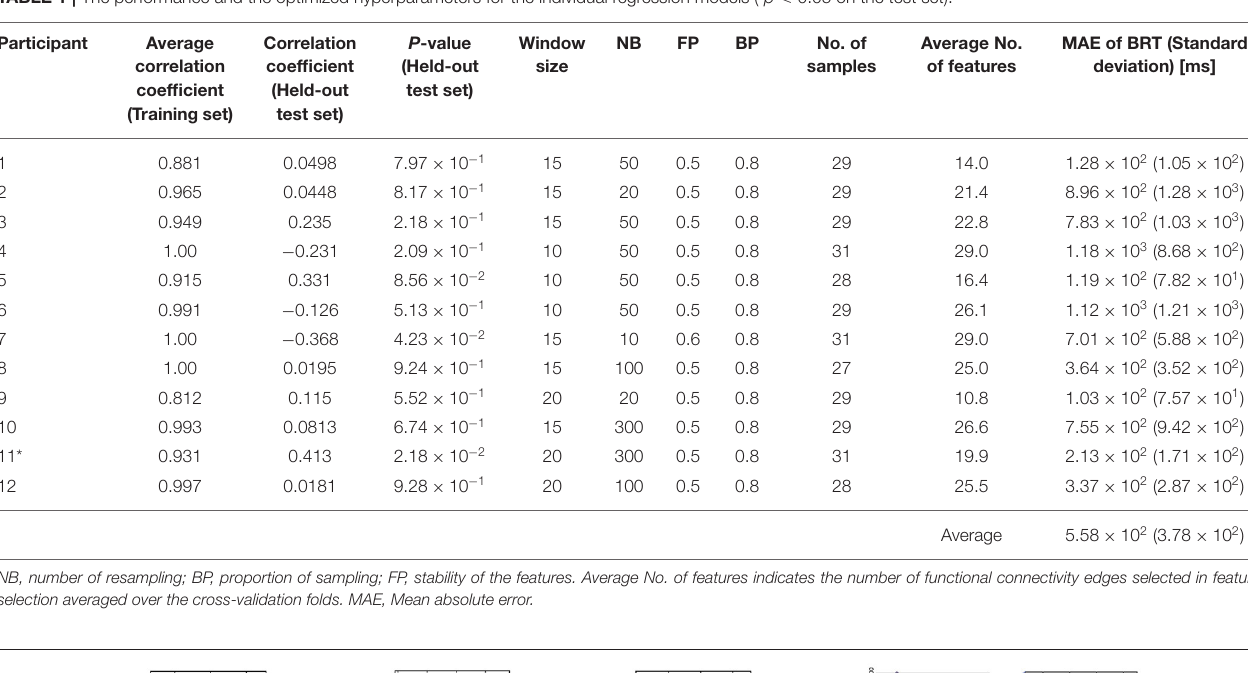
on the dendrogram indicates the distance threshold used for splitting into 5 clusters). Commonly selected FC edges in clusters are shown in the connectome plot. The connectome is also represented as a circle plot. The color of the node in the circle plot indicates which of the six well-known brain functional networks (dorsal attention network: DAN, default mode network: DMN, sensorimotor network: SMN, ventral attention network: VAN, frontoparietal network: FPN, and salience network: SN)